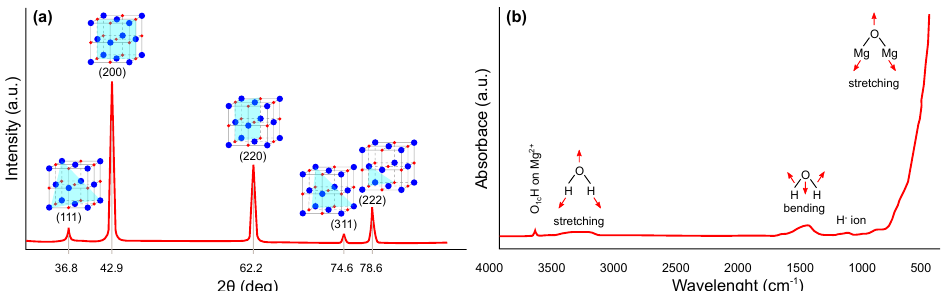
Figure 3. Structural characterization of magnesium oxide: ( a ) XRD pattern and ( b ) FTIR spectra (redrawn and adapted from the results presented in [26–30,37–40]).